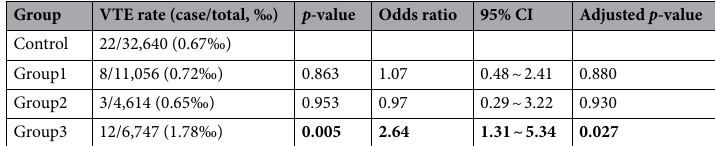
Table 3. Rate of VTE in different AR conditions. Significant values are in bold. Group 1: with AR before; without AR after childbirth. Group 2: without AR before; with AR after childbirth. Group 3: with AR before; with AR after childbirth. Adjusted p -value: adjusted for AS, medical comorbidities, pregnancy characteristics, delivery complications, urbanization, jobs, age and birth type.